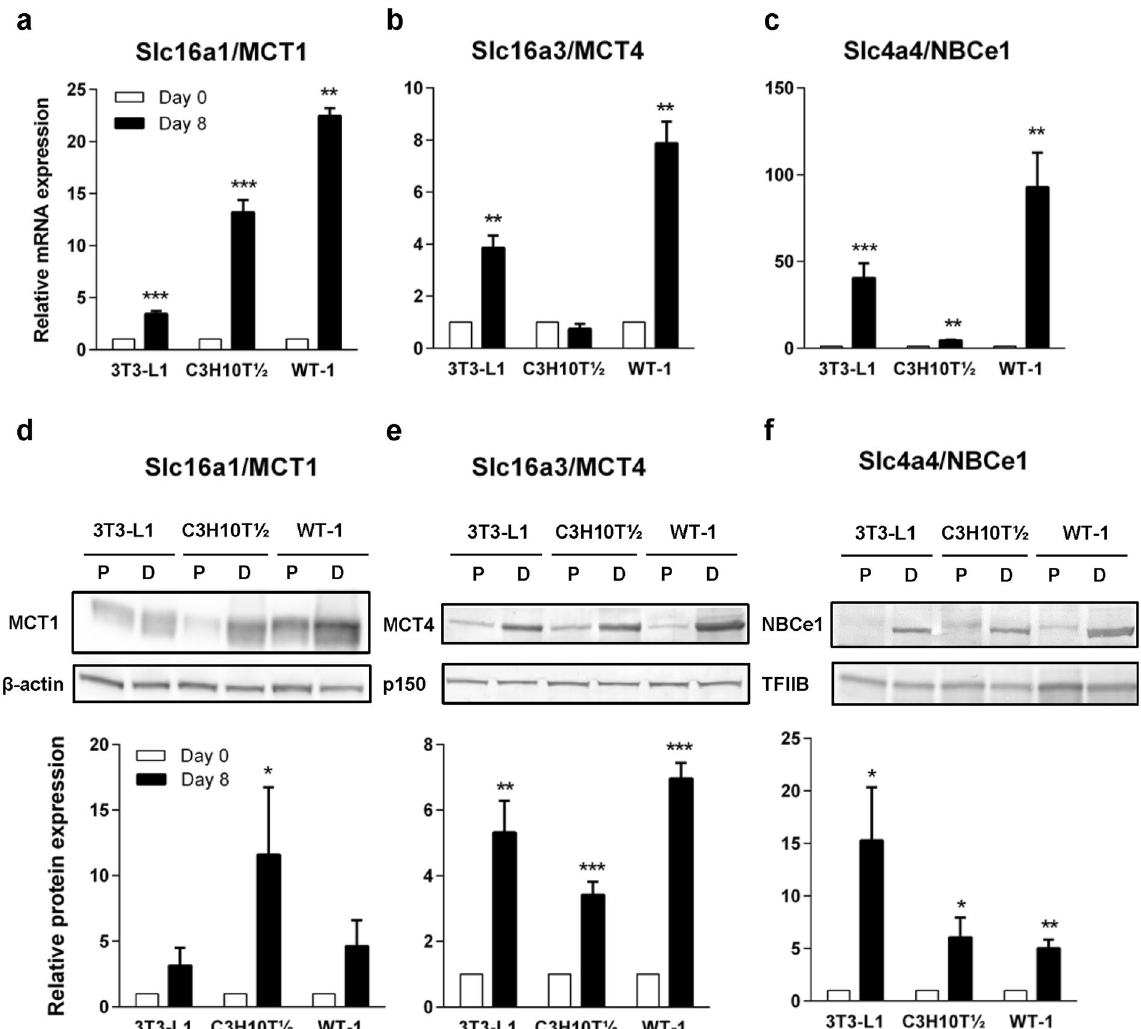
Figure 2. mRNA and protein levels of MCT1, MCT4, and NBCe1 are increased upon adipocyte differentiation. 3T3-L1, C3H10T½ and WT-1 pre-adipocytes were grown to confluency and either lysed and processed for mRNA extraction and qPCR analysis ( a – c ) or for SDS-PAGE and immunoblotting ( d – f ) at this point (day 0) or induced to differentiate into adipocytes as described in Materials and Methods, and harvested for qPCR analysis on day 8. TBP was used as a reference gene, and the Pfaffl method was applied to determine relative expression levels. The fold increase in mRNA level relative to that at day 0, of ( a ) MCT1, ( b ) MCT4, ( c ) NBCe1 is shown. Data are shown as mean with S.E.M. error bars, and represent 3 independent biological replicates for each gene. * , ** and *** : Significantly different from corresponding day 0 value, at p < 0.05, 0.01, and 0.001, respectively, paired two-tailed Students t -test. Panels d-f show the fold increase in protein level relative to that at day 0, of ( d ) MCT1, ( e ) MCT4, and ( f ) NBCe1. Representative blots are shown above each graph, with β -actin, p150 Glued and TFIIB as loading controls. Membranes were cut horizontally before blotting and edges slightly cropped for presentation. Graphed data are shown as mean with S.E.M. error bars, and represent 3–6 biological replicates for each cell type. P: pre-adipocyte, D: differentiated. ** and ** Significantly different from corresponding day 0 value, at p < 0.01 and 0.001, respectively, paired two-tailed Students t